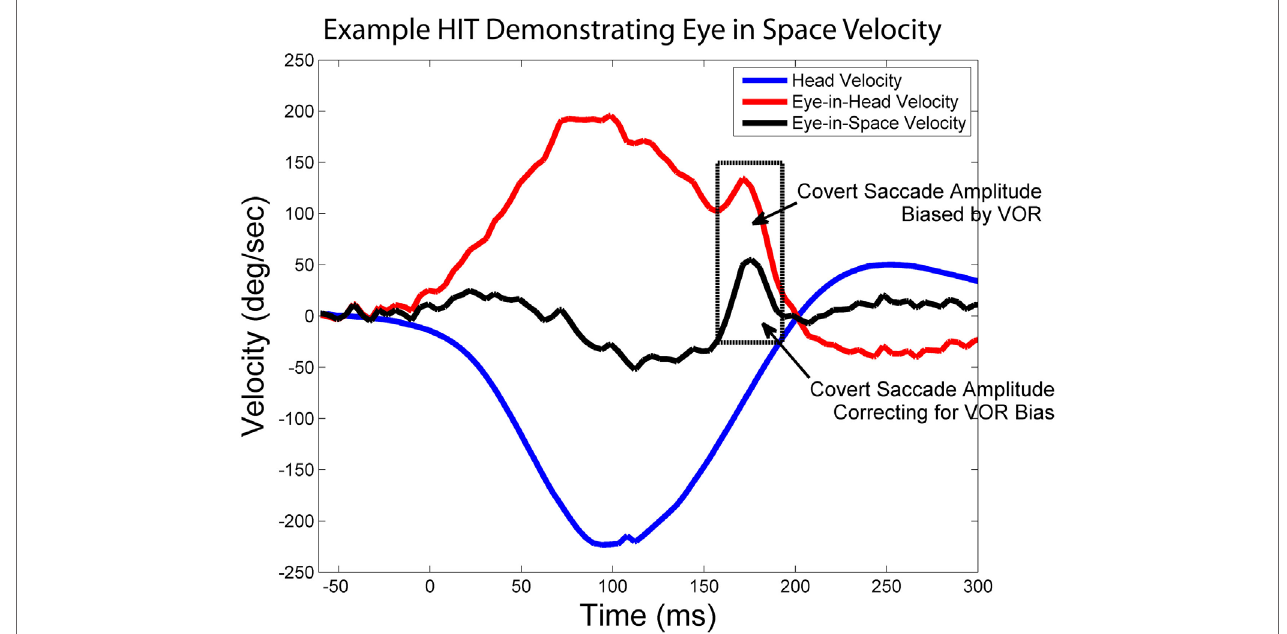
FigUre 2 | calculating eye-in-space velocity . Exemplar vHIT showing how the sum of head velocity (blue) and eye-in-head velocity (red) can be used to calculate eye-in-space velocity (black). The boxed in area highlights a covert saccade and demonstrates how using eye-in-space rather than eye-in-head velocity to calculate saccade amplitude removes the bias that results from VOR-mediated eye